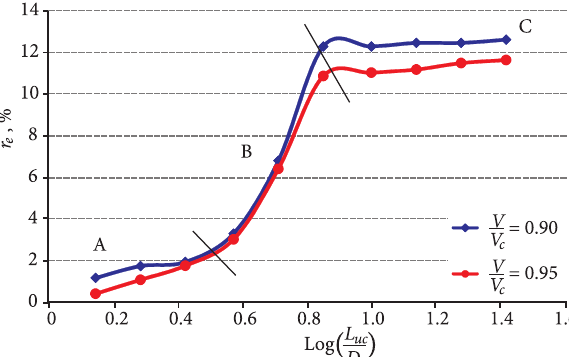
Fig. 6. Two-sided collars